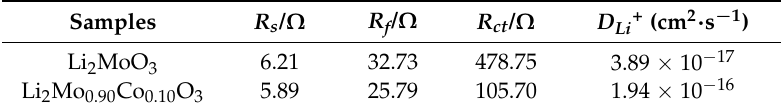
Table 1. Fitting results of EIS plots.